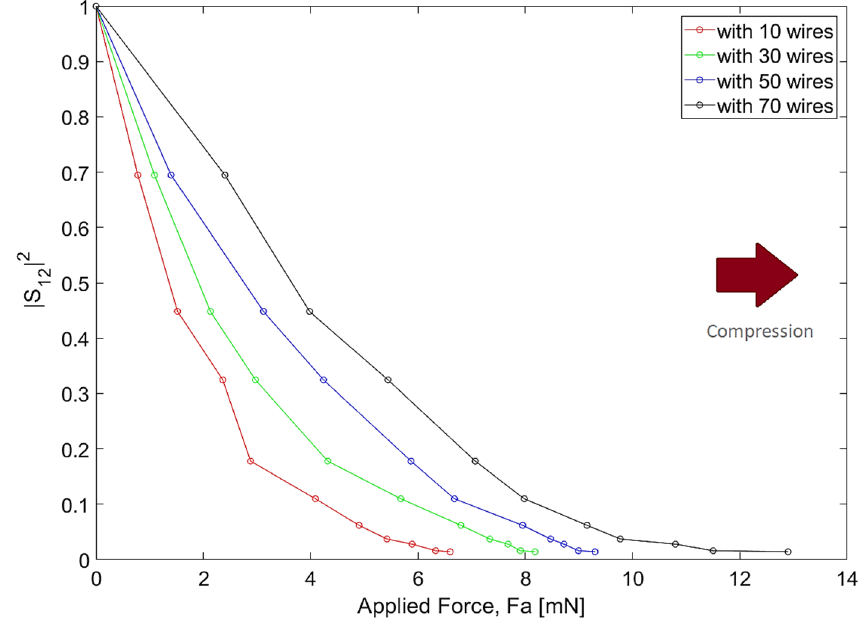
Figure 13. Reflectance as a function of applied force for 10, 30, 50 and 70 wires and a filter assembled with HDPE.